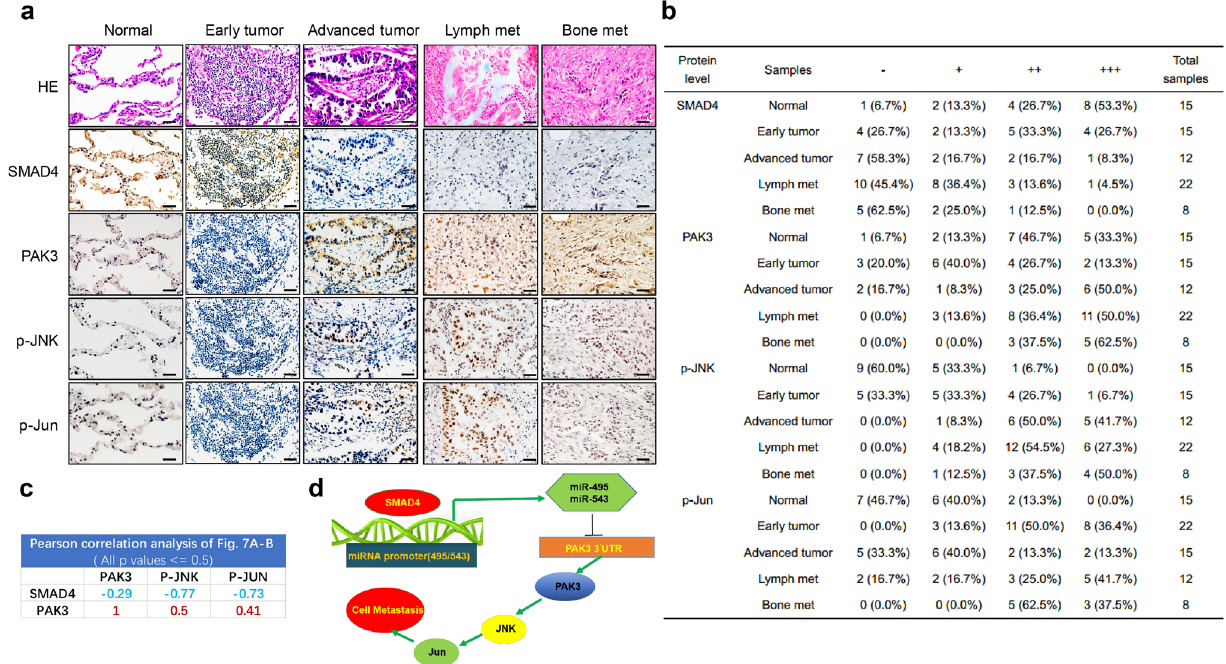
Fig. 7 Correlation between Smad4 and PAK3/JNK/Jun expression in human lung cancer samples. a Representative IHC images displaying an inverse correlation between Smad4, PAK3, p-JNK, and p-Jun in human normal lung tissues, lung tumors, and lung cancer metastatic samples. Scale bar, 25 μ m (magni fi cation, ×40). b Statistics of positively stained percentages in human normal lung tissues ( n = 15) and lung cancer metastatic tissues: early tumor ( n = 15); advanced tumor ( n = 12); lymph nodes metastases ( n = 22); bone metastases ( n = 8). c Pearson correlation analysis of protein expressions in Fig. 7a, b. d A proposed model for the role of Smad4 in lung cancer